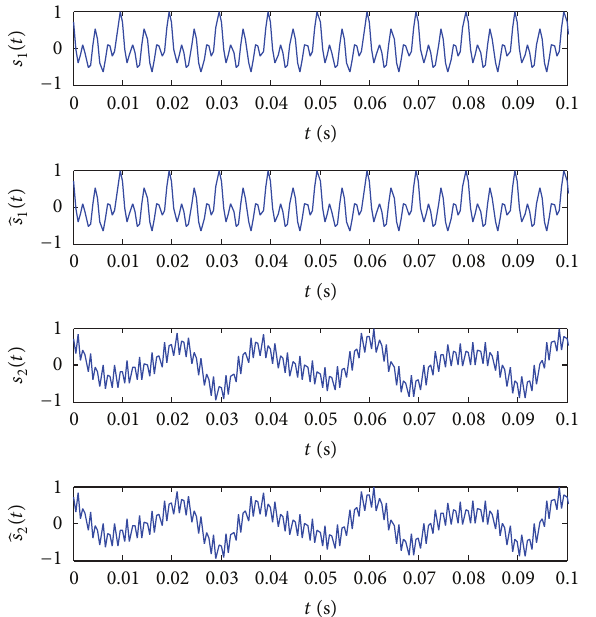
Figure 4: Numerical results of proposed BSS algorithm ( 𝐿 = 70 ).